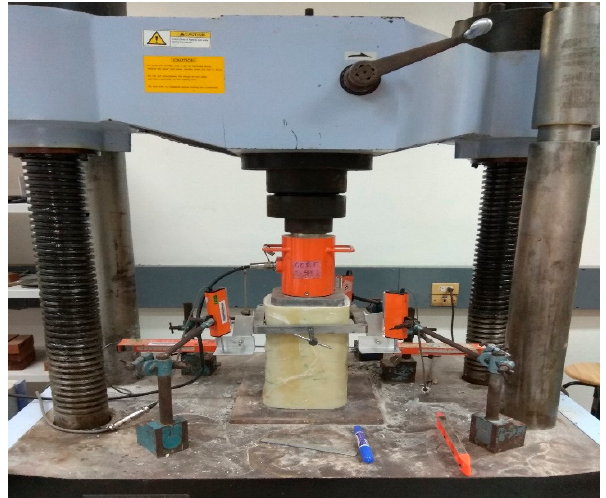
Figure 7. Test setup for square specimens.